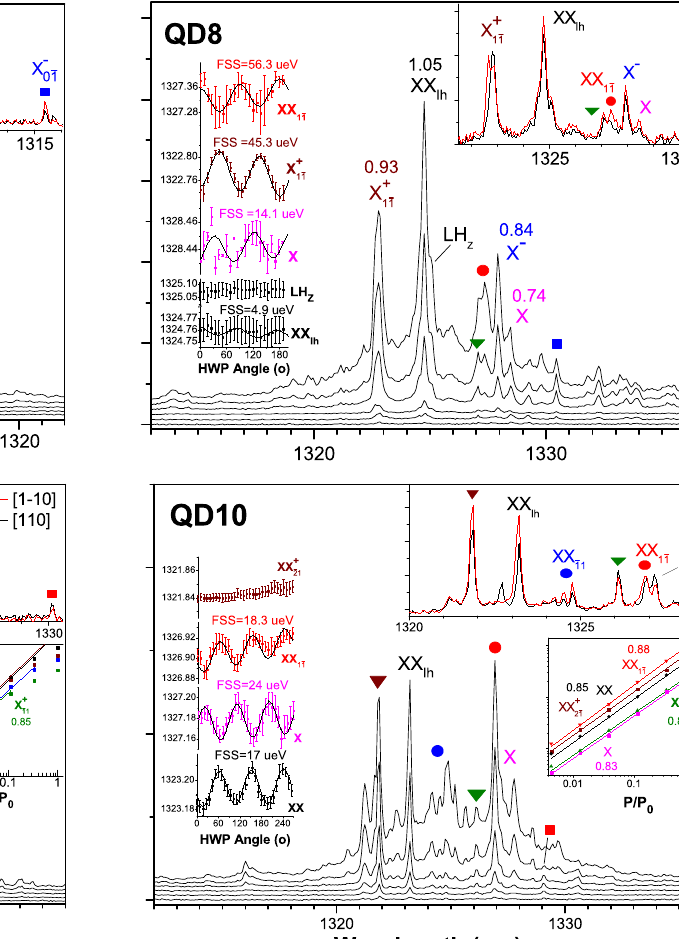
Figure 5. μ PL spectra of QD11–15 with dominant XX lh in various FSS. QD13–15 with charge field to vary FSS oscillation phase and show phonon-related spectral shoulder. QD14 in similar spec- trum as QD9. ( Top-right ): statistics on XX lh FSS as measured.